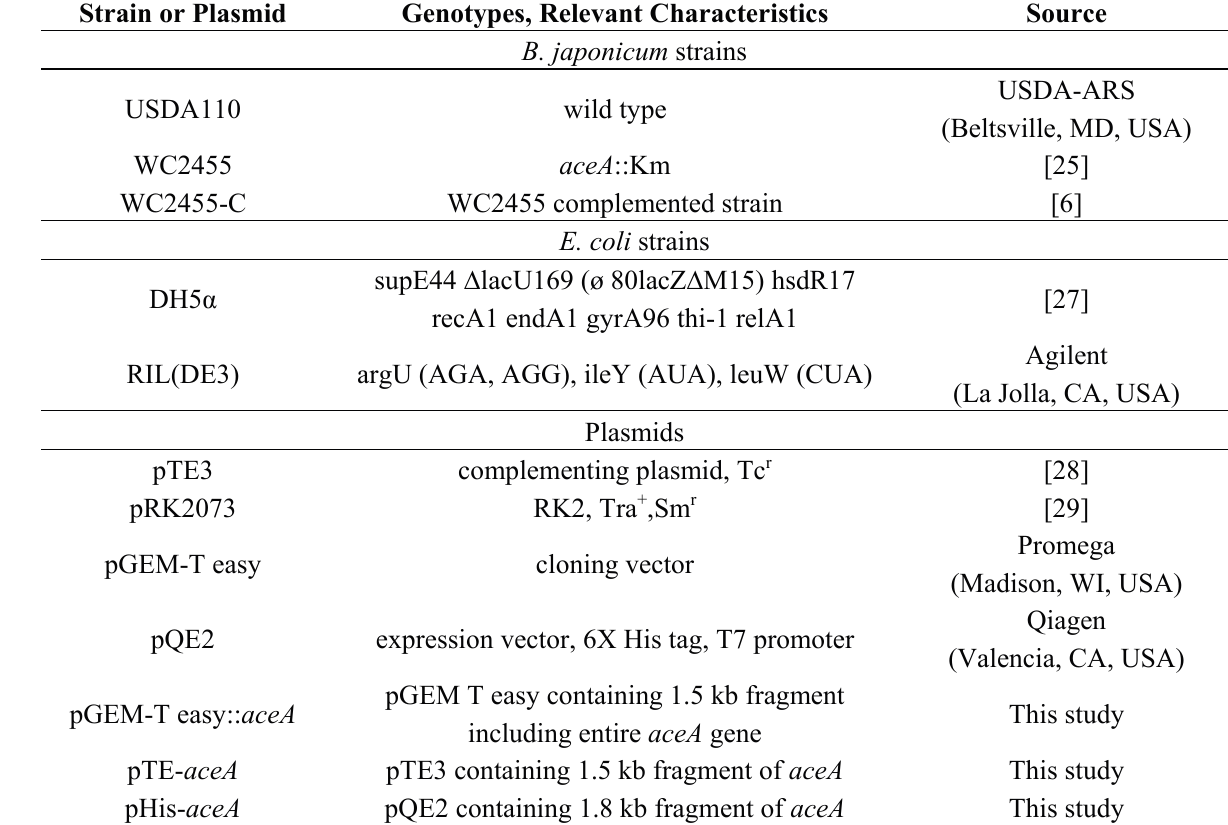
Table 4. Bacterial strains and plasmids used in this